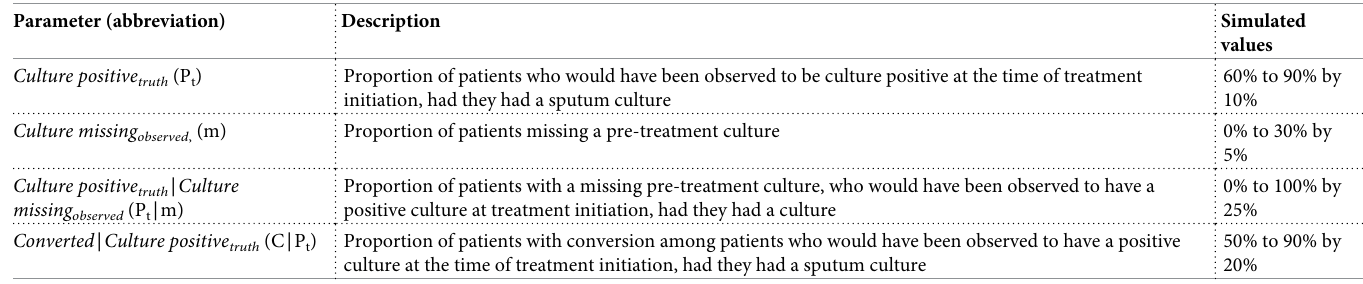
Table 1. Parameters and values, simulation study of bias due to early death and loss-to-follow up events occurring during a hypothetical post-treatment initiation sputum collection interval among participants missing a pre-treatment sputum